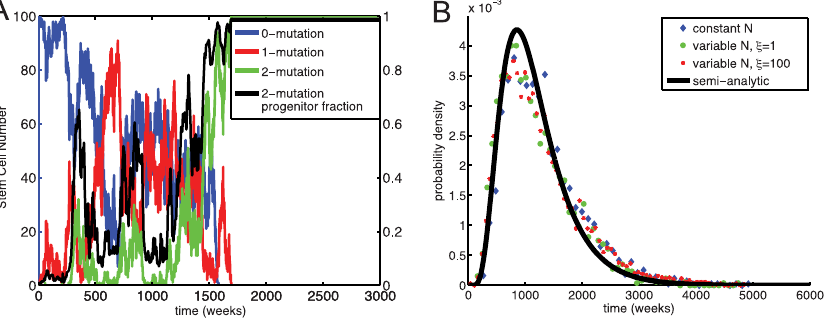
Figure 3. Times to fixation without dedifferentiation. (A) Typical simulation trajectory for constant stem cell population size and mutation rate u ~ 0 : 1 . The numbers of zero-, one-, and two-mutation stem cells are shown in blue, red, and green, respectively. The proportion of two-mutation cells in the progenitor population is shown in black. (B) Times to fixation for constant and variable stem cell population size models. Histograms of waiting times to fixation of two-mutation cells for constant (blue) and variable stem cell population size with high fluctuations (green, j ~ 1 ) and low fluctuations (red, j ~ 100 ). The semi-analytic distribution of waiting times calculated from Eq. (12) is shown in black. In both panels the mutation rate u ~ 0 : 01 .